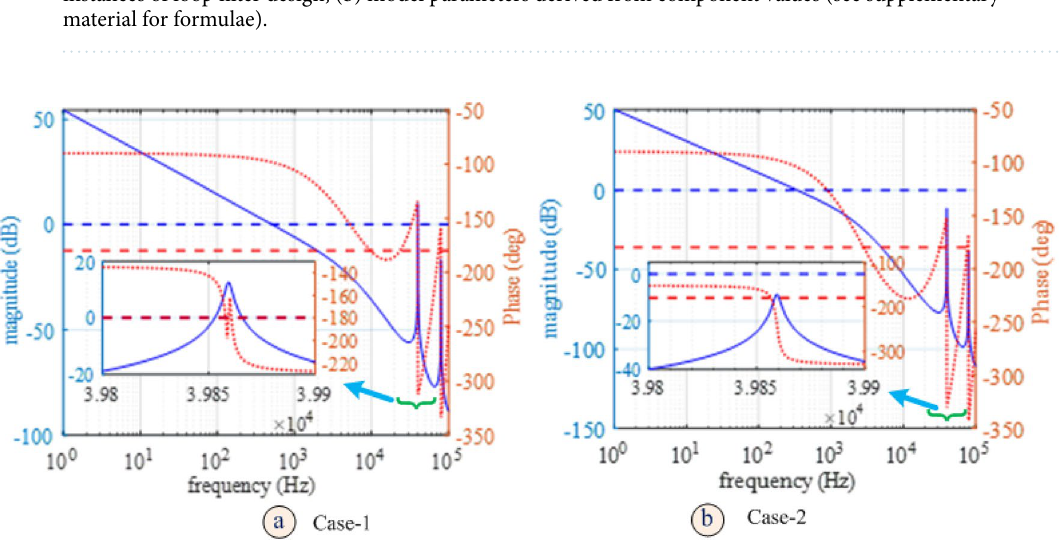
Figure 7. Open loop Bode plot for the PLL-OEO for the two different loop filter designs considered. The inset shows the first side-mode resonance for two different sets of loop filter component values listed in Table